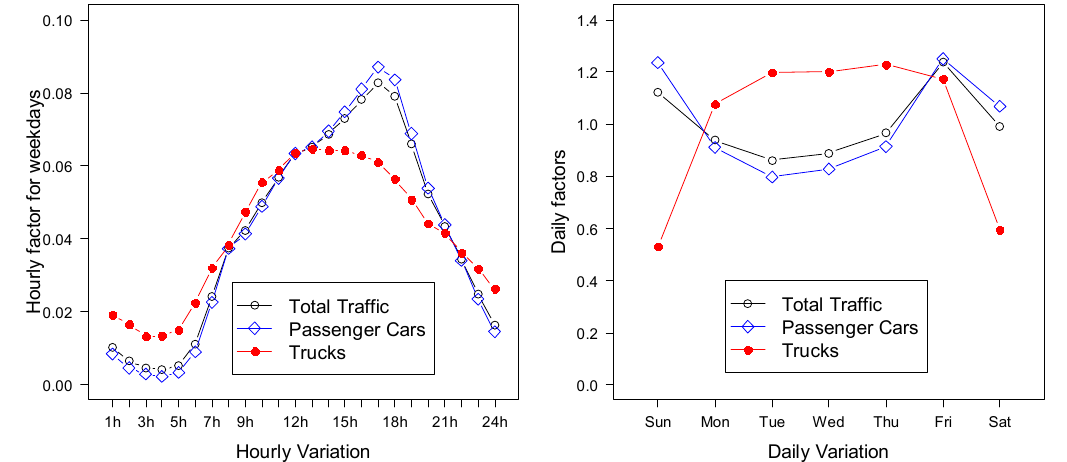
Geosciences 2019 , 9 , x FOR PEER REVIEW Figure 4. Typical hourly and daily variations of traffic at Leduc Highway 2. Figure 4. Typical hourly and daily variations of traffic at Leduc Highway 2. Figure 4. Typical hourly and daily variations of traffic at Leduc Highway 2.